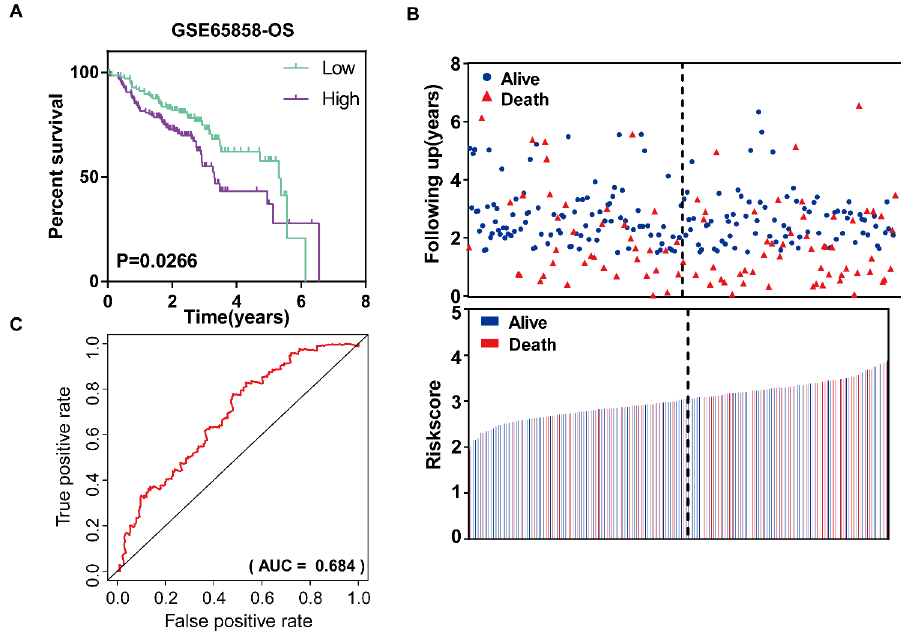
Fig. 4 The relationship of the ERS-related signature with clinical characteristics of HNSCC patients. ( A ) The strip chart of risk score and clinical character- istics for patients with HNSCC in TCGA datatset. ( B ) Pie charts showing the Chi-squared test of clinicopathologic factors for low- and high- risk groups in HNSCC samples from TCGA